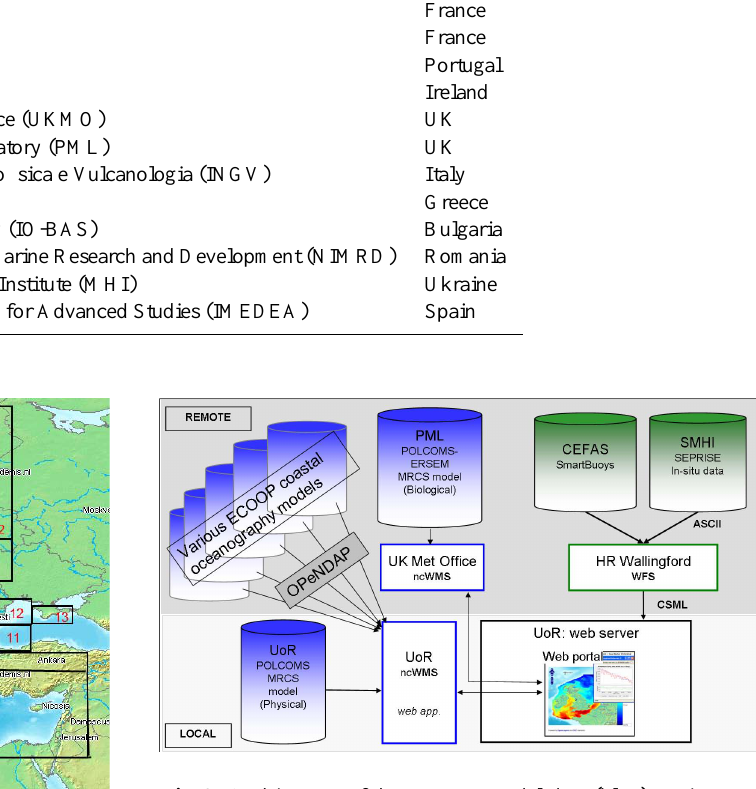
Fig. 2. Architecture of the system. Model data (blue) are ingested into the portal via an instance of ncWMS at the University of Read- ing (UoR), and an instance of ncWMS at the UK Met Office. in situ data (green) are ingested into the portal via the WFS at HR Wallingford serving CSML